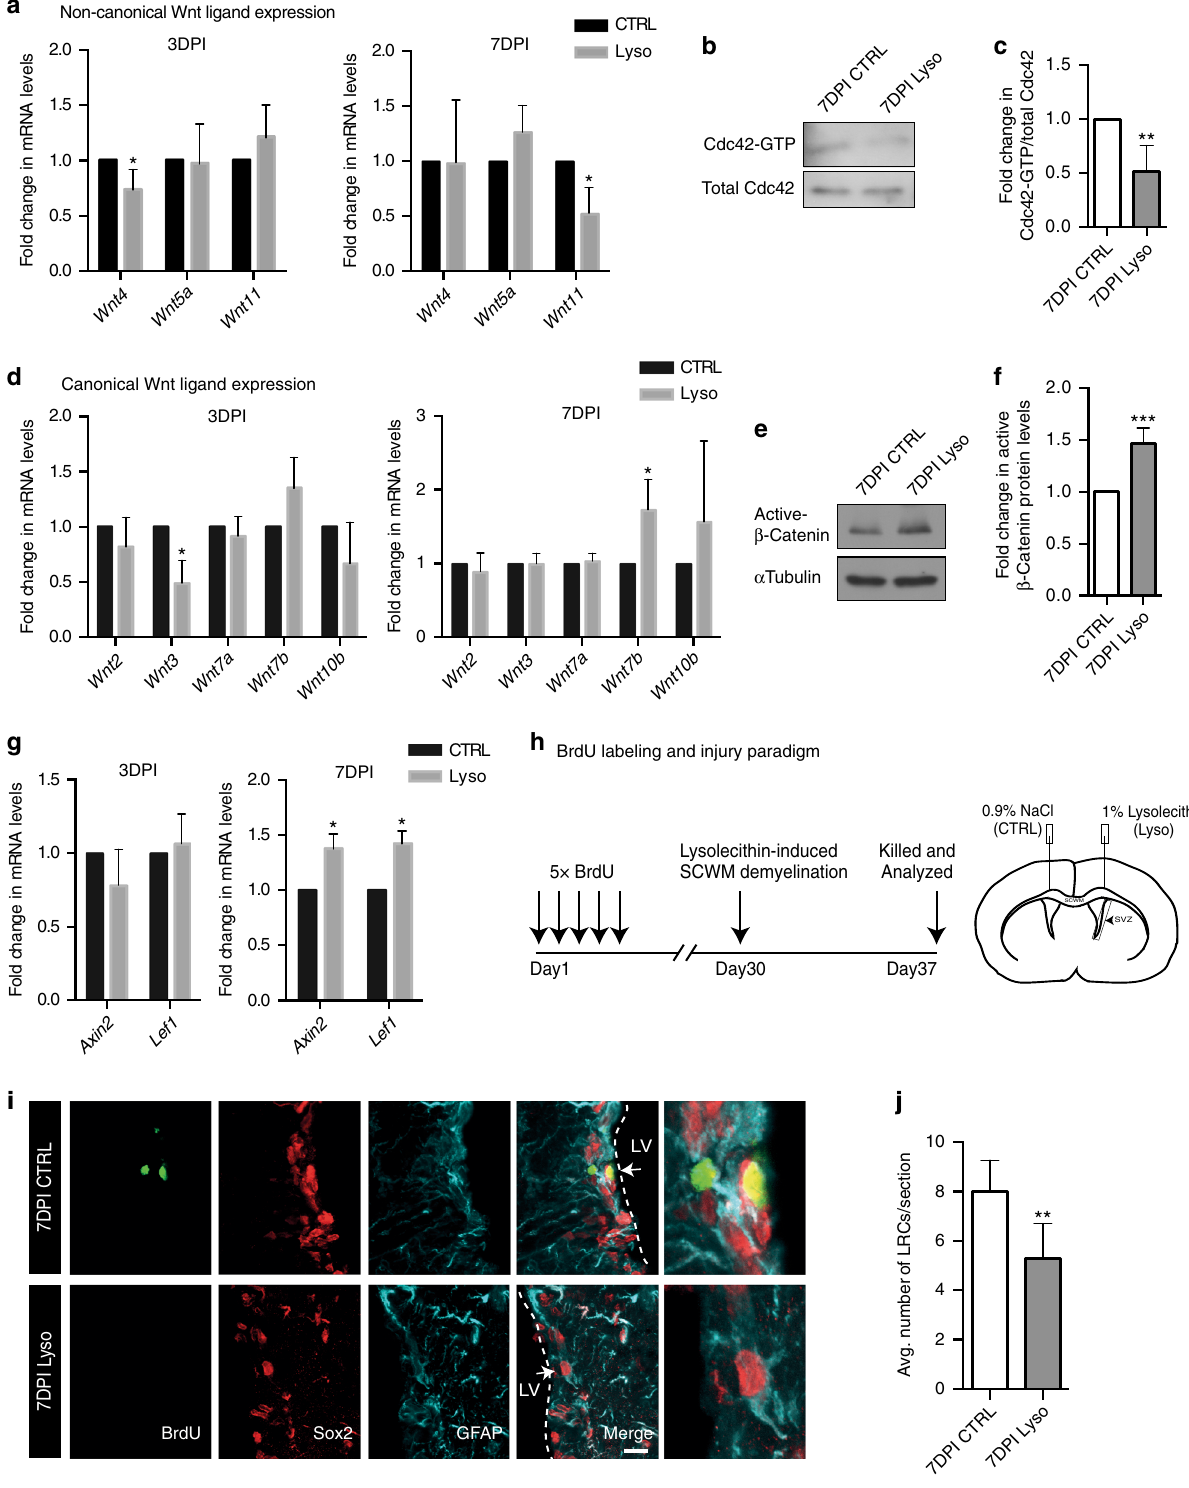
Non-canonical Wnt preserves functional quiescence in the SVZ . As our results indicated that a disruption in the balance between non-canonical and canonical Wnt signaling promotes activation of quiescent NSCs, we asked if we could halt this process by force inducing non-canonical Wnt signaling in the SVZ during demyelination. To this end, we used a gain-of- function approach using non-canonical Wnt (Wnt5a) or control